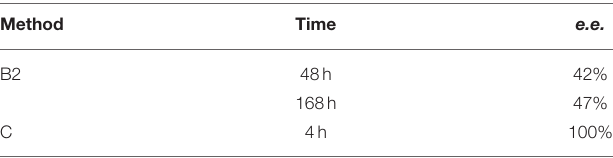
TABLE 3 | Results of biotransformation of the racemic mixture of (3 ′ pirydyl)methylphosphonic acid (substrate 2 ) with immobilized biocatalyst (agar-agar entrapment).